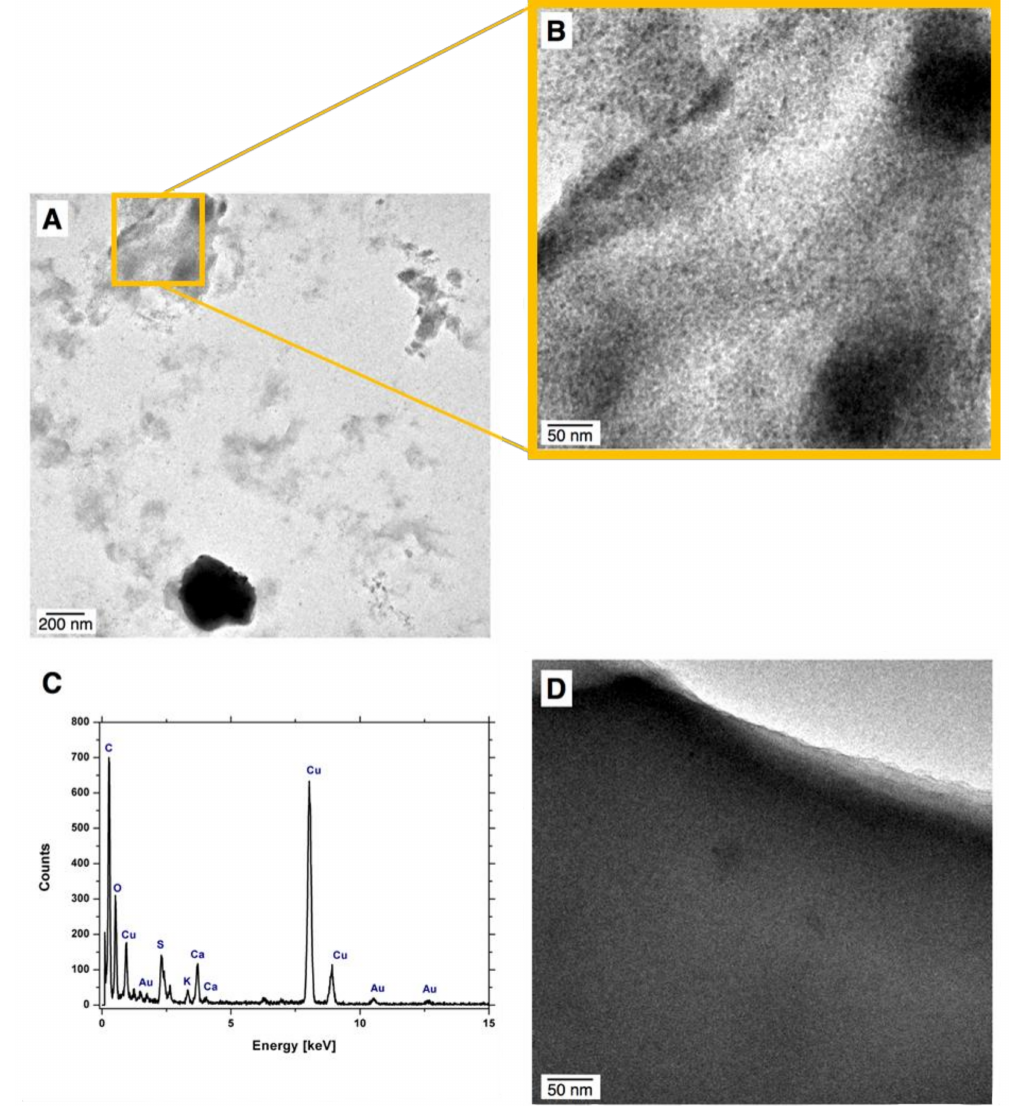
Figure 4. The characteristics of the produced nanocomposites; ( A , B ) transmission electron microscopy (TEM) photomicrographs of the NC3 sample; ( C ) energy dispersive X-ray (EDS) analysis of the region presented in Figure 4B; and ( D ) TEM photomicrograph for the NC1